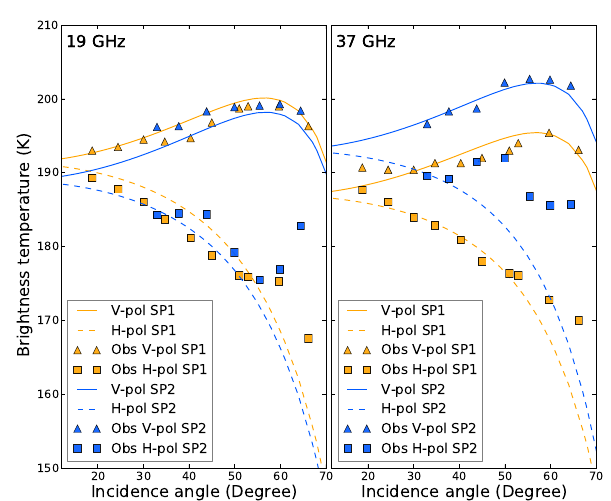
Figure 6. Measured and modeled brightness temperature as a func- tion of the incidence angle for two locations (SP1 in orange and SP2 in blue), at horizontal (dashed curve and squares) and vertical (solid curve and triangles) polarizations, and at 19GHz (left) and 37GHz (right) frequencies.